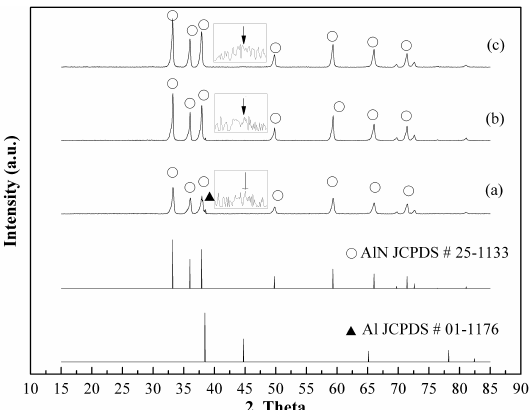
Figure 7. XRD patterns of AlN/Al powders prepared by the plasma pre-synthesis process (1.2 kW, Al/NH 4 Cl = 1/1, and 550 °C for 2 min) followed by thermal nitridation at ( a ) 850 °C, ( b ) 950 °C, ( c ) 1050 °C (heating rate: 15 °C/min, held for 1 h).